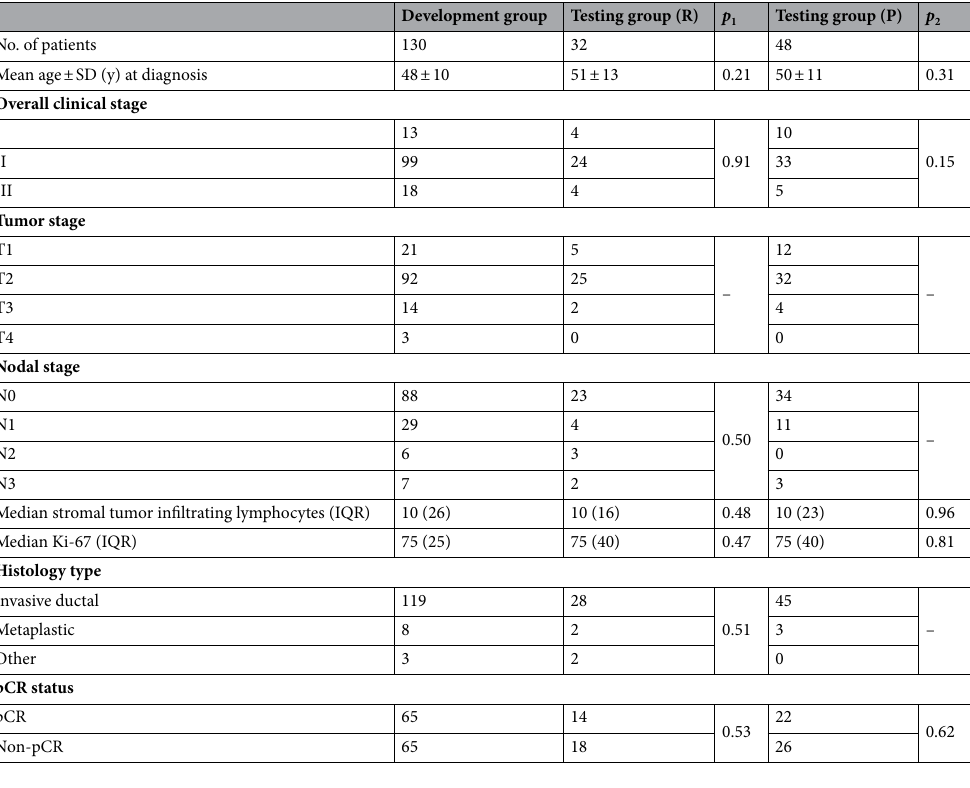
Table 1. Characteristics of the study patients. Testing group (R): retrospective independent testing group. Testing group (P): prospective blinded testing group. p 1 : p-value of the comparison between the development and the retrospective independent testing groups. p 2 : p-value of the comparison between the development and the prospective blinded testing groups. The groups’ ages were compared using a t-test; stromal tumor infiltrating lymphocytes and Ki-67 were compared using the nonparametric Mann–Whitney U test; and other non-continuous variables were compared using the chi-squared test. SD standard deviation, IQR interquartile range, pCR pathologic complete